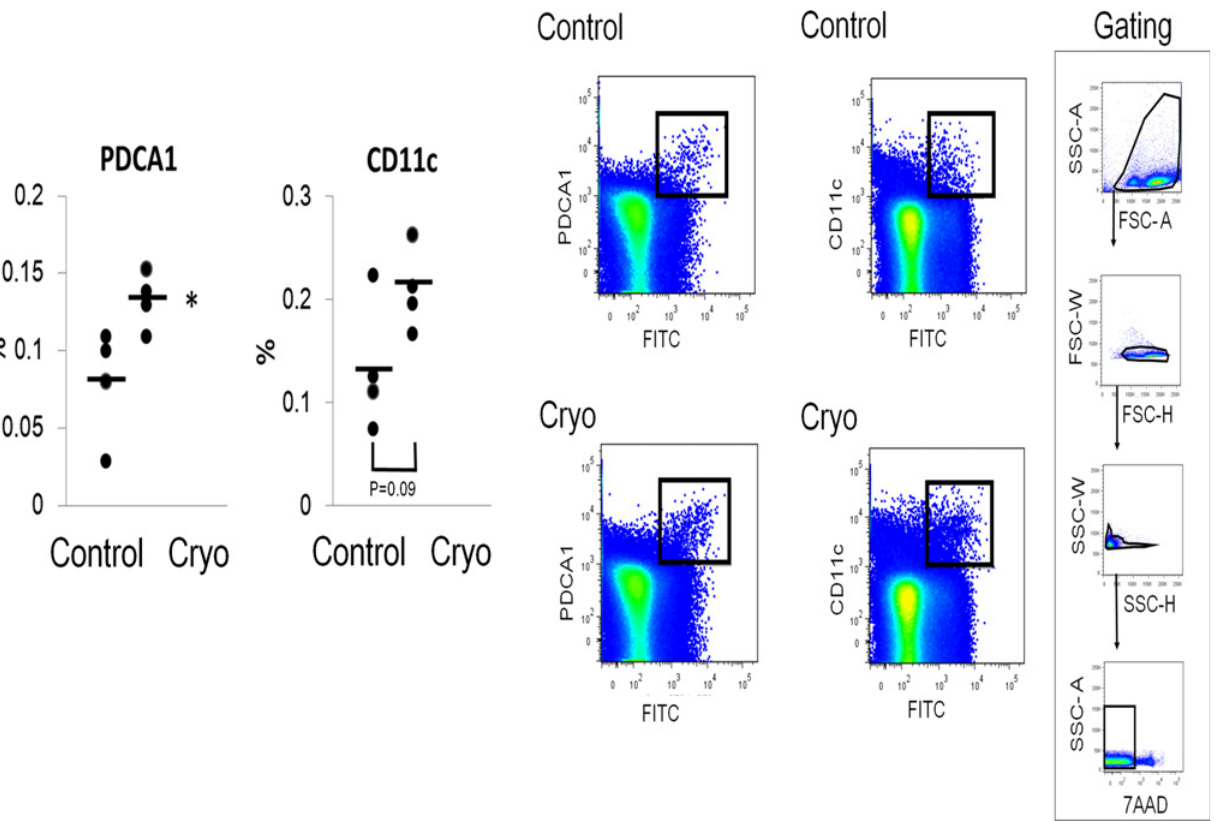
Fig 7. Migration assay of dendritic cells to regional lymph nodes. Flow cytometry analysis for migrated FITC + CD11c + myeloid dendritc cells and FITC + PDCA1 + plasmacytoid dendritc cells. Gating strategy is also shown. Cryo; cryoablation. All data are shown as dots. Bars represent the mean values. Significant differences between the means are indicated, * P < 0.05 versus control. n = 4, in each